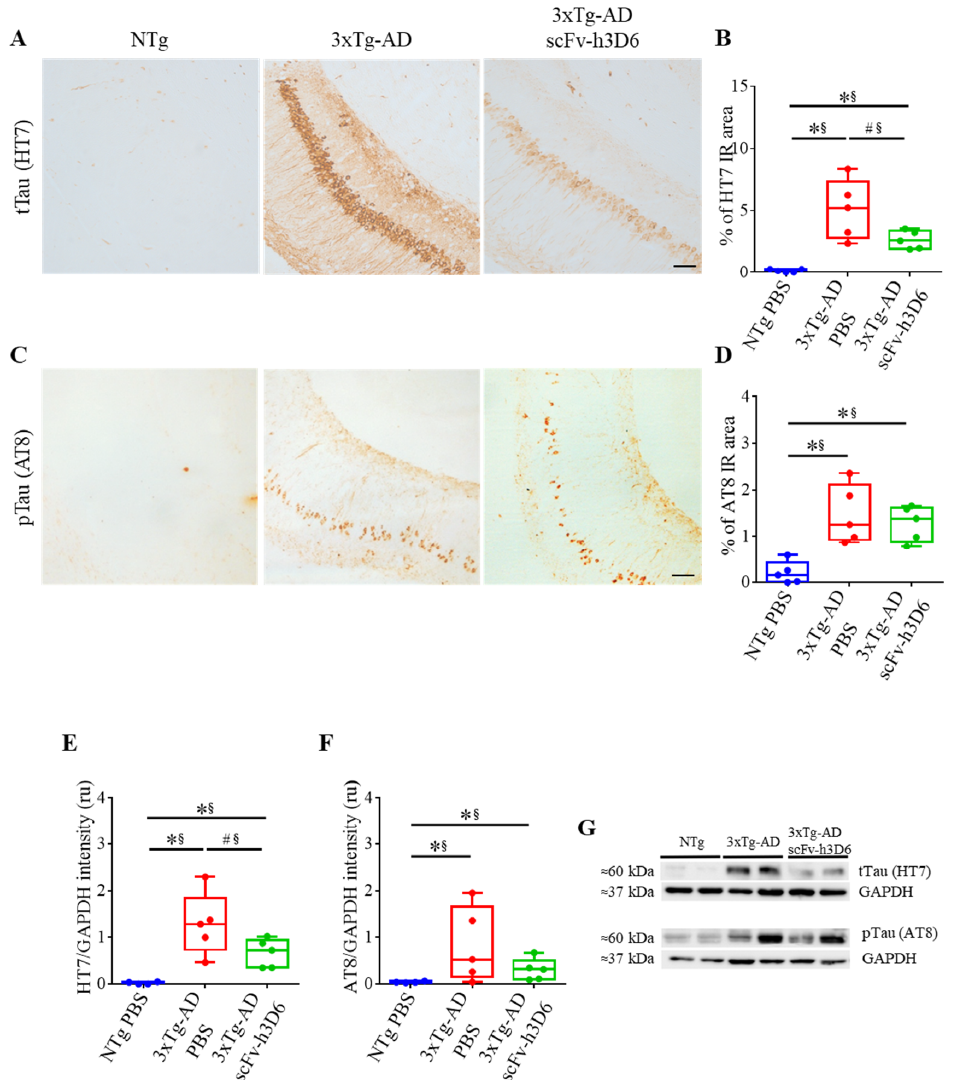
Figure 4. ScFv-h3D6 treatment tends to decrease the total tau load in the hippocampus. ( A ) Total tau (HT7) labeling in untreated NTg (left), untreated 3xTg-AD (center), and scFv-h3D6-treated 3xTg-AD (right) mice. ( B ) Percentage of HT7-immunoreactive area. ( C ) Ser202 and Thr205 Phosphorylated tau levels (AT8) labeling in untreated NTg (left), untreated 3xTg-AD (center), and scFv-h3D6-treated 3xTg-AD (right) mice. Scale bar 25 µ m. ( D ) Percentage of the AT8-immunoreactive area. ( E ) Total tau levels (HT7) in the SDS-soluble fractions, as measured by Western blotting and normalized by GAPDH levels. Intensity is expressed in relative units. ( F ) Ser202 and Thr205 Phosphorylated tau levels (AT8) in the SDS-soluble fractions, as measured by Western-blotting and normalized by GAPDH levels. Intensity is expressed in relative units. ( G ) Representative Western-blot image of the total and phosphorylated tau protein in the SDS-soluble fractions from the untreated NTg, untreated 3xTg-AD, and scFv-h3D6-treated 3xTg-AD mice. Three replicates for each experiment. Data are expressed as medians in box plots, and whiskers represent the minimum and maximum values. Statistical di ff erences were assessed with the non-parametrical test U Mann-Whitney. * Significant di ff erences p ≤ 0.05; # Marginal significance p ≤ 0.1; § r ≥